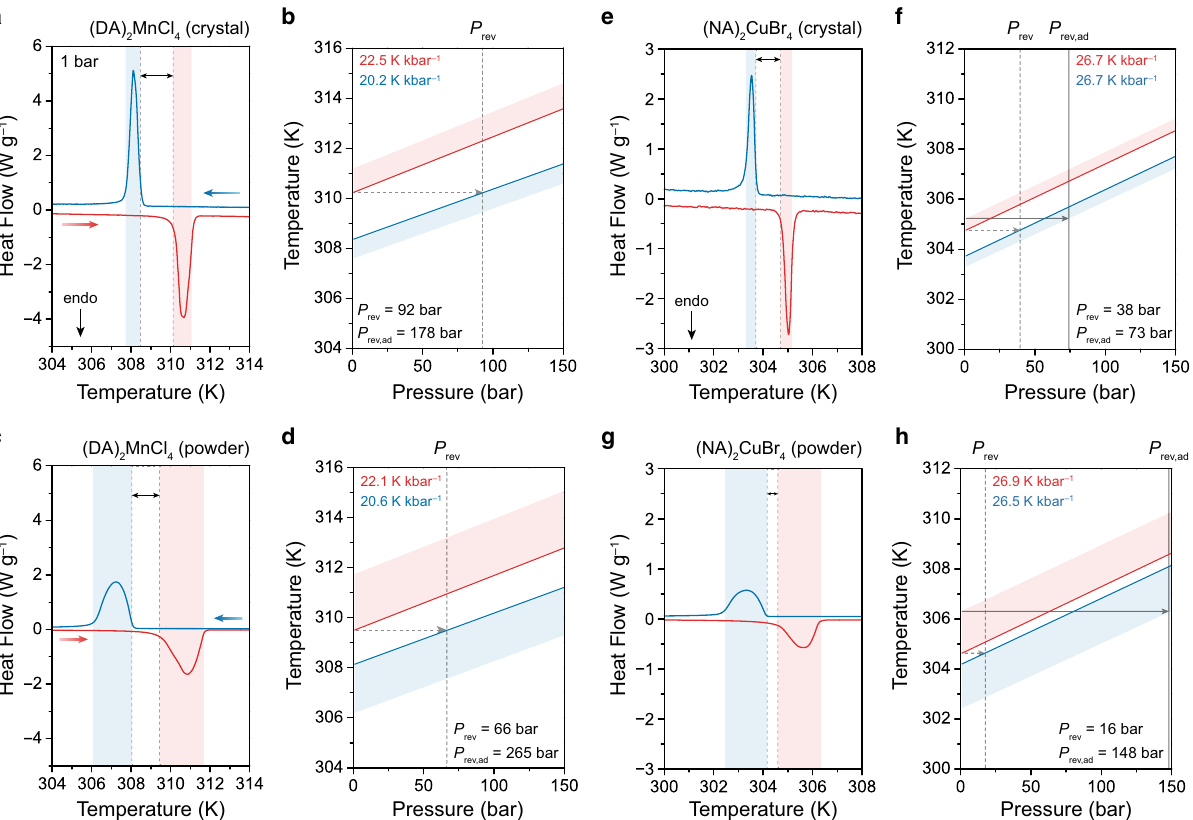
Fig. 4 Dependence of low-pressure reversibility on thermal contact. The phase boundary determined from HP-DSC experiments for ( a – d ) (DA) 2 MnCl 4 and ( e – h ) (NA) 2 CuBr 4 , using ( a , b , e , f ) single-crystal samples with improved thermal contact and ( c , d , g , h ) powder samples. Scan rates of 2 K min – 1 were used for all experiments, and He was used as the pressure-transmitting medium. DSC traces at ambient pressure are show in the left panel, with transition peak width highlighted in red and blue shades for heating and cooling, respectively. Onset temperatures are highlighted in dashed gray lines, with thermal hysteresis marked using black arrows. The pressure dependence of the onset and completion transition temperatures is shown in the right panels, and these phase boundaries illustrate the impact of the transition width on the minimum pressure required to drive a reversible isothermal entropy change ( P rev ) and a reversible adiabatic temperature change ( P rev,ad ). Note that the isobaric HP-DSC data for the powder samples is shown in Supplementary Fig. 16. Reversible barocaloric effects for powder and single-crystal samples are summarized in Supplementary Table 7.